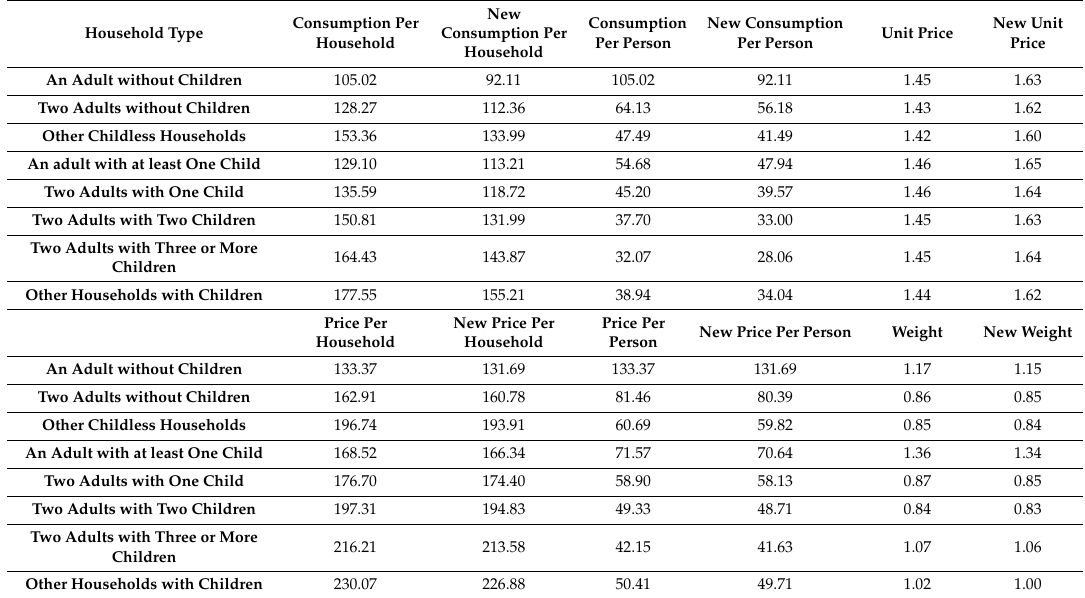
Table A2. Values before and after the Price Variation Introduced by Household Type.